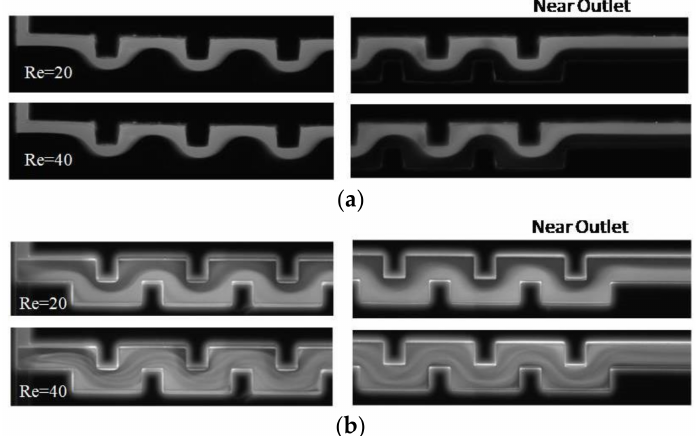
Figure 10. Experimental results. Micrographs for the intensity distribution in serpentine channels (at Re = 20 and 40) integrated with the ( a ) simple T-junction and ( b ) vortex T-junction. In the case of the serpentine channel with the simple T-mixer, the height of the channel is equal to the height of the inlet channels. In such a situation, the heights of the serpentine channel with the simple and vortex T-junctions are 100 µ m and 200 µ m,